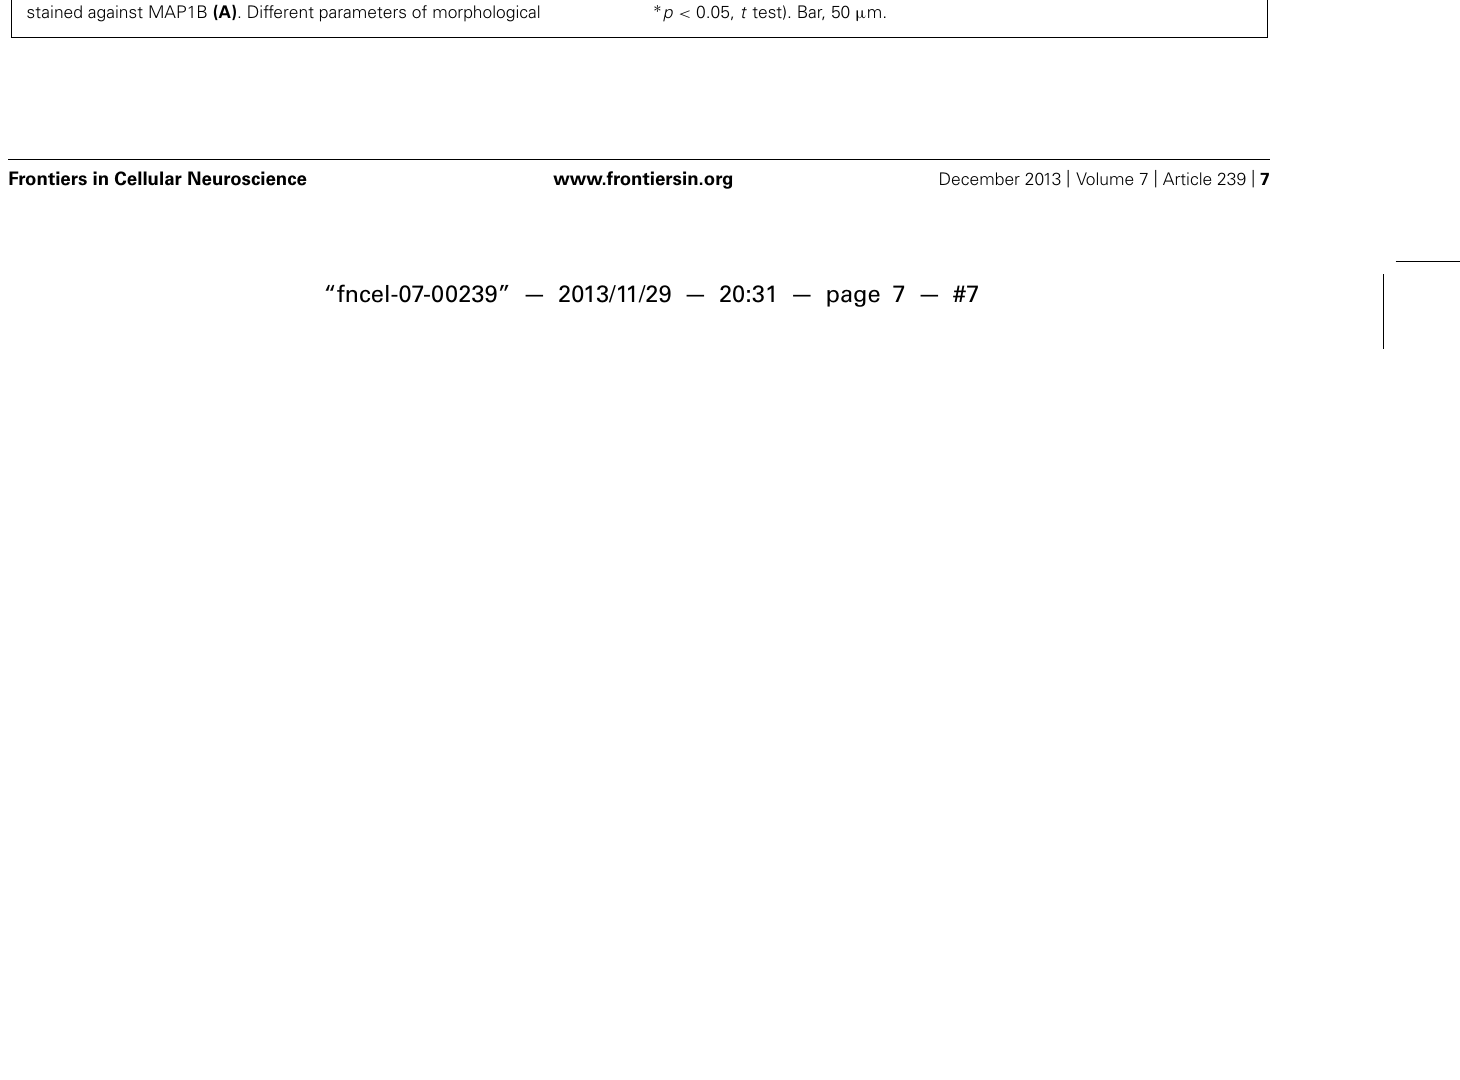
FIGURE 4 |A small proportion of NSC-hSOD1G93A cells display neurite outgrowth. NSC34hSOD1WT and NSC34hSOD1G93A cells were plated in PLL/gelatin-coated coverslips and differentiated for 24 h. Cells were fixed and stained against MAP1B (A) . Different parameters of morphological